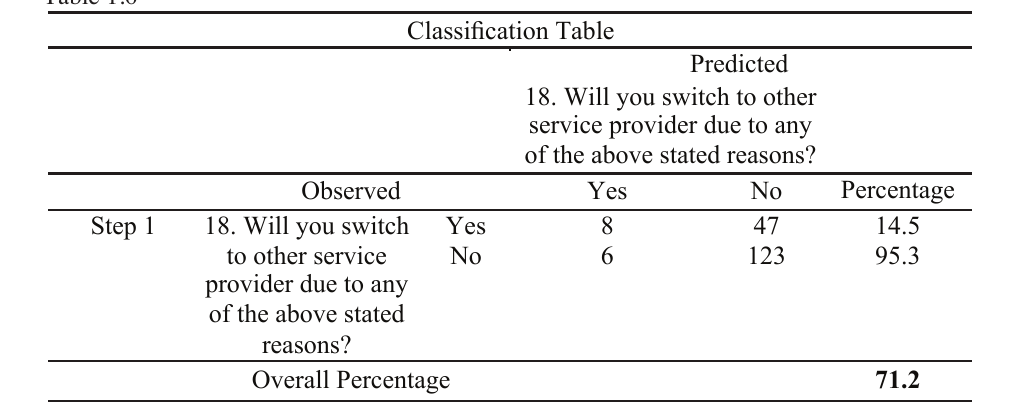
Cox & Snell R Negelkerk Square R Square